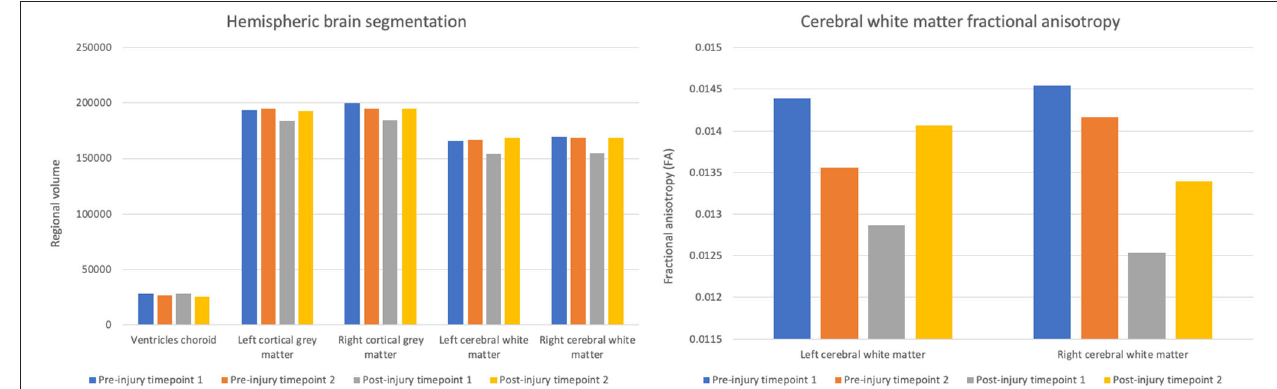
FIGURE 2 | Volumes of choroid ventricles, hemispheric gray matter, and hemispheric white matter and fractional anisotropy of the hemispheric cerebral white matter across scanning timepoints.